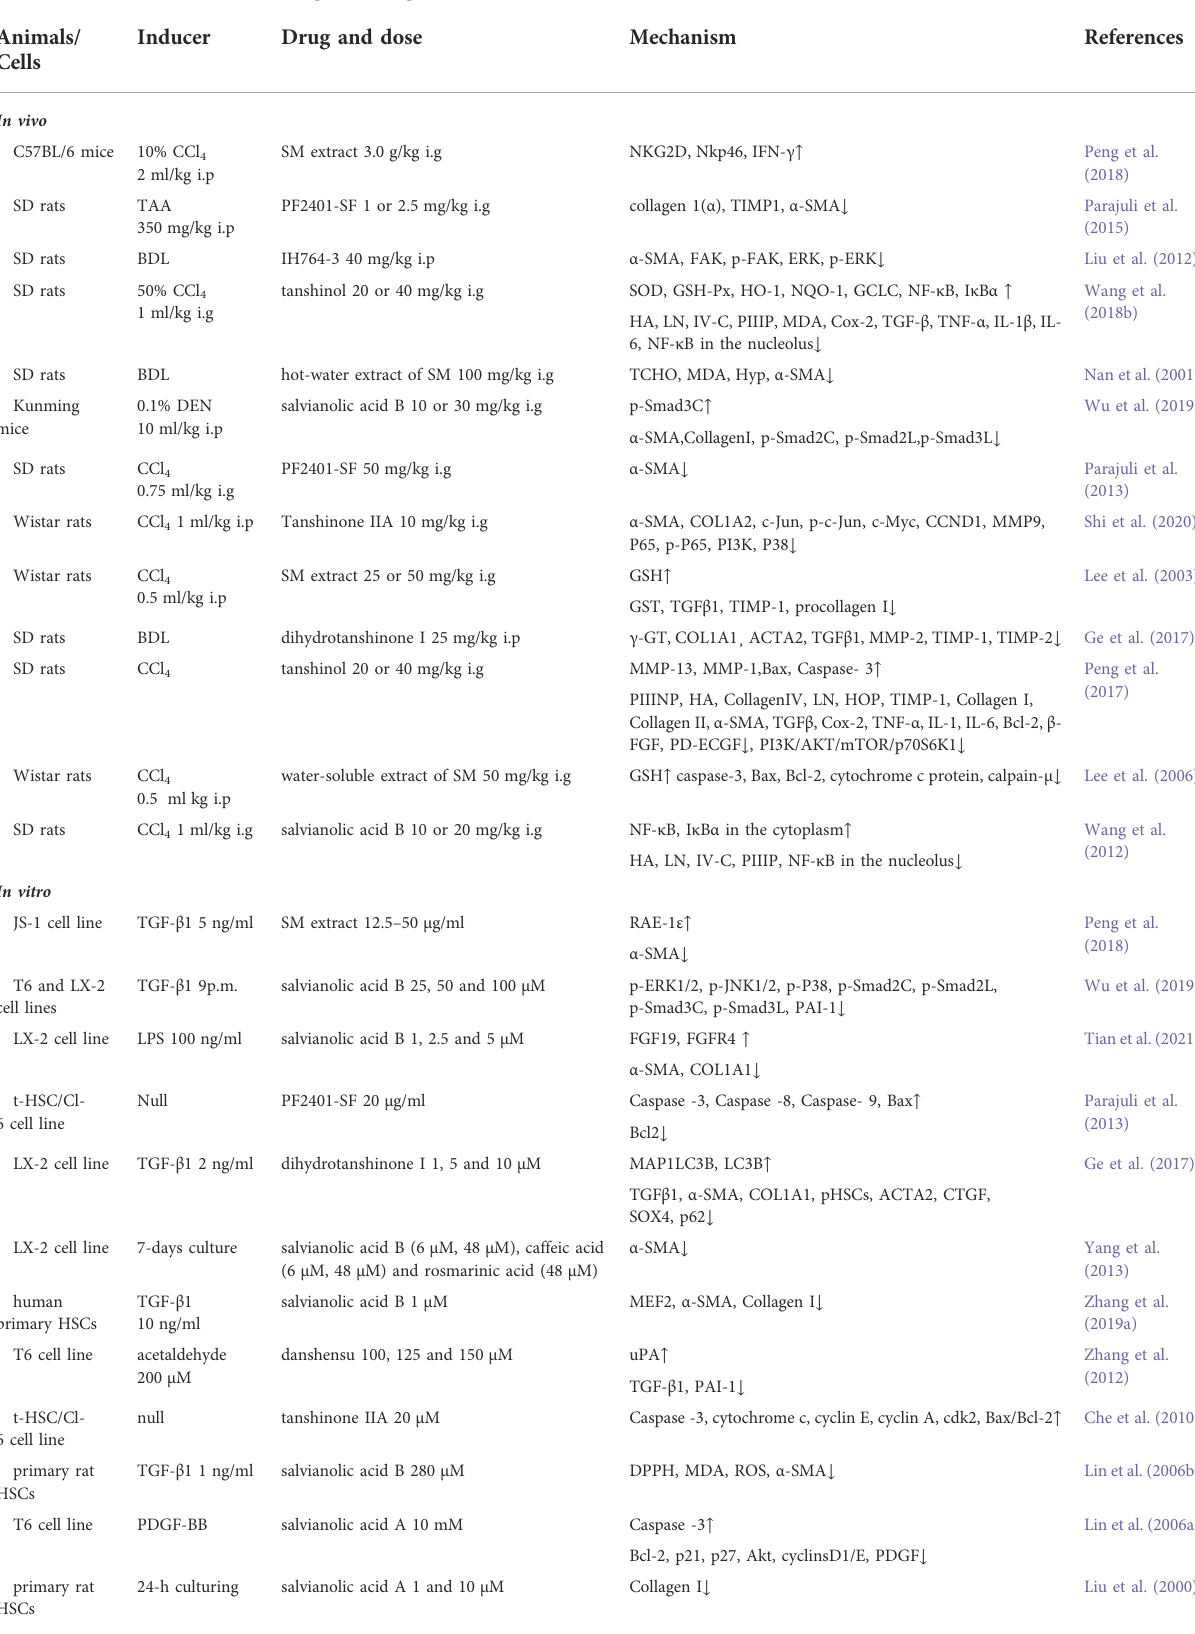
TABLE 1 Effects of SM and its active ingredients against liver fi brosis in vivo and in vitro . Animals/ Inducer Drug and dose Cells In vivo C57BL/6 mice 10% CCl 4 2 ml/kg